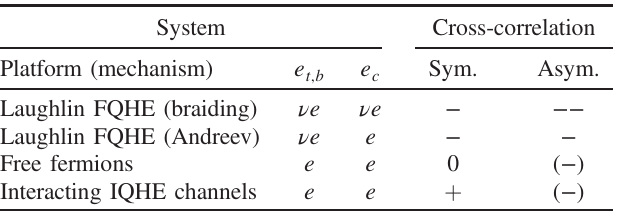
TABLE I. Cross-correlations with dilute beams of incident quasiparticles. Both the cross-correlation sign and evolution between symmetric sources (Sym.) and a single source (Asym.) are compulsory to distinguish between different transport mech- anisms involving tunneling quasiparticles of charge e theses indicate a signal that emerge for nondilute incident beams, and a −− signifies a larger amplitude. See Ref. [35] for the predictions of positive cross-correlations with two interacting channels of the integer quantum Hall effect (IQHE) and Refs. [36,37] for the prediction and observation of an Andreev mechanism giving rise to symmetry-independent negative cross- correlations when the analyzer is set to favor the tunneling of